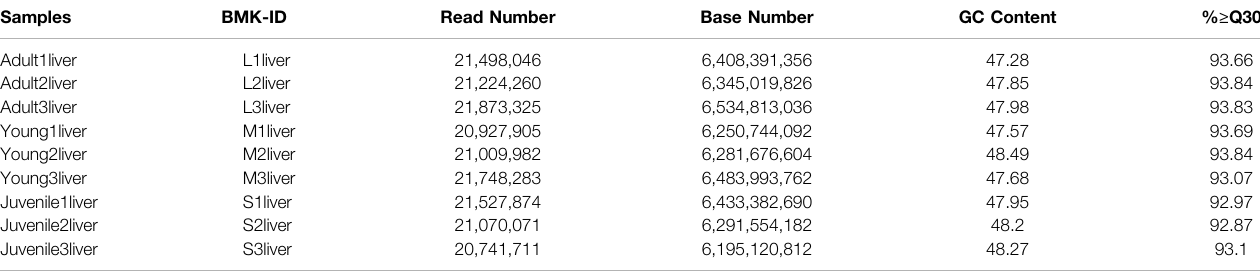
TABLE 1 | Statistical table for sample sequencing data evaluation. Samples